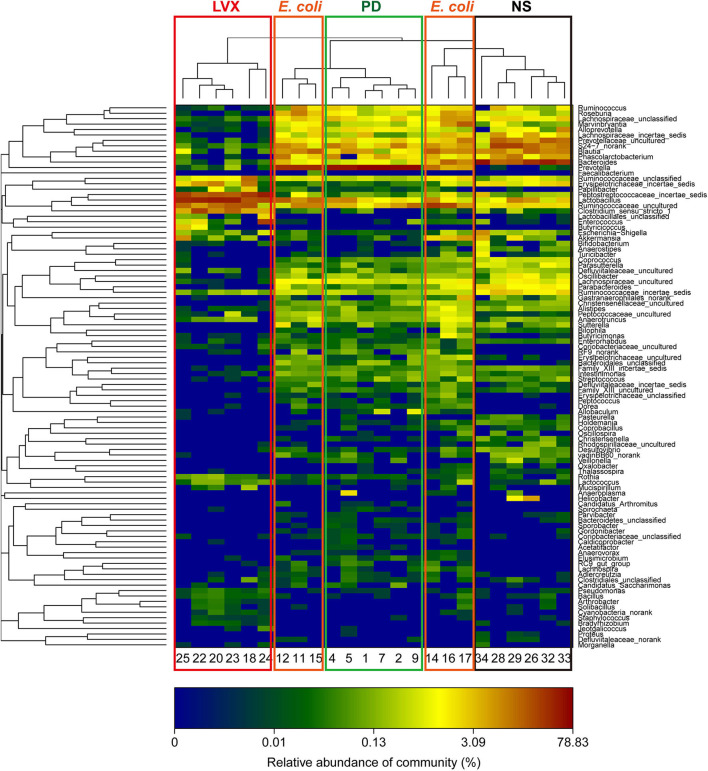
Heatmap of hierarchy cluster indicated the amount of genus in feces. Colors reflect relative abundance from low (blue) to high (red).